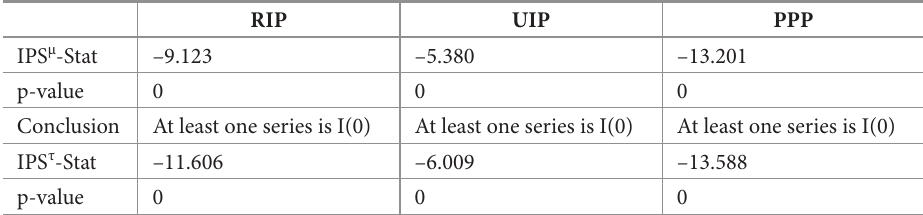
table 4. Summary statistics of IPS panel data unit root